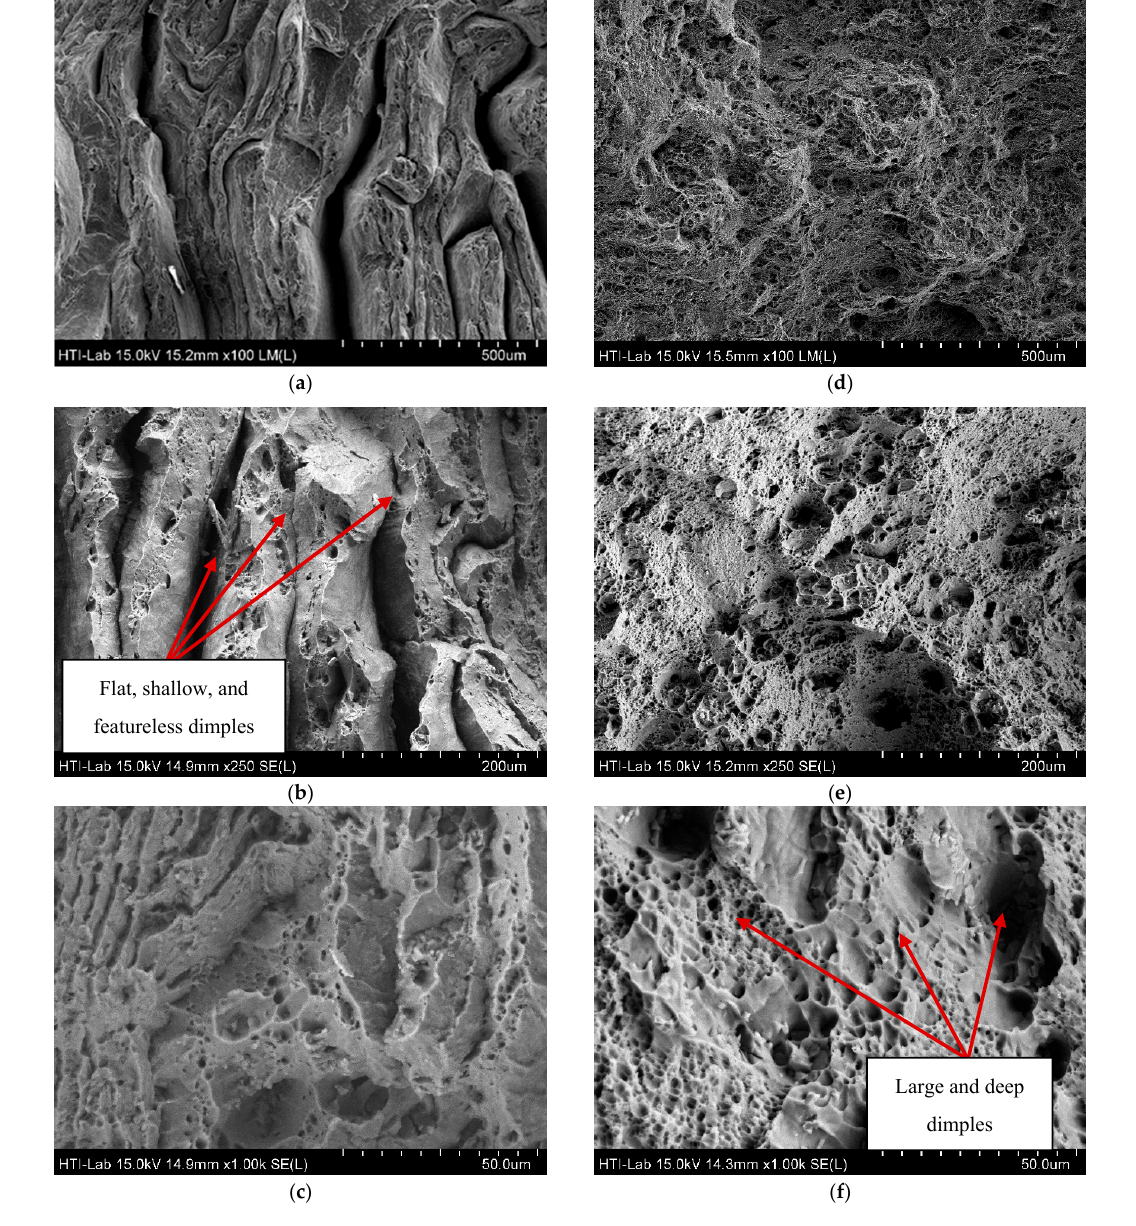
Figure 10. FESEM micrographs showing the fracture surface of the profiles at the heat-treated sample S10-T5 and as-received AR-T6: ( a ) S10-T5 (heat treated) − 100×; ( b ) S10-T5 (heat treated)-250×; ( c ) S10-T5 (heat treated)-1000×; ( d ) AR-T6 (As-received)-100×; ( e ) AR-T6 (As-received)-250×; and ( f ) AR-T6 (As-received)-1000×.